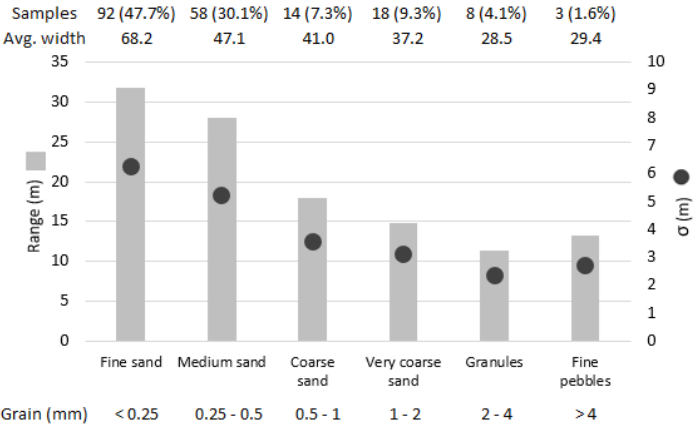
Figure 7. For the different grain size grading categories (according to Wentworth [70]): number of samples, average beach width (m), and average range (grey boxes) and standard deviation (black dots) of the SDS as variability proxies when considering 100 m buffers.